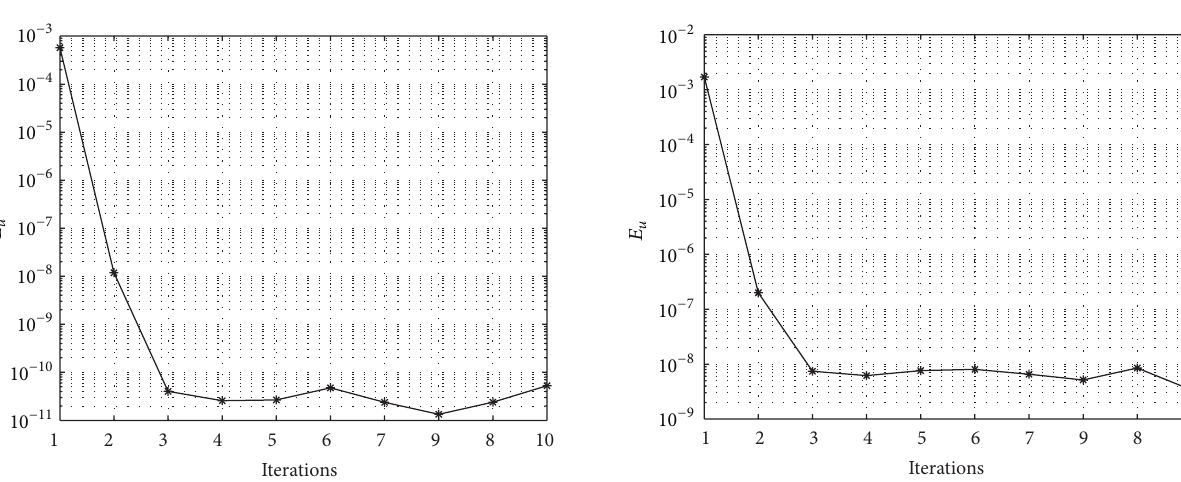
Figure 15: Fitzhugh-Nagumo equation convergence graph.